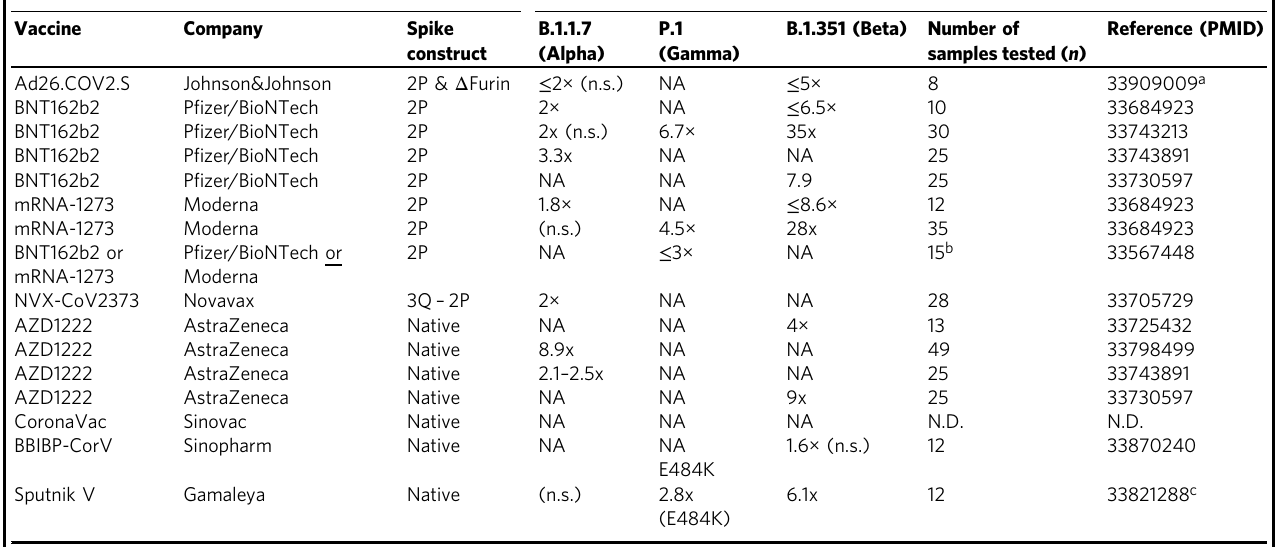
Table 2 Summary of post-vaccine sera evaluated for neutralization potency against the indicated SARS-CoV-2 variants of concern (VOC).